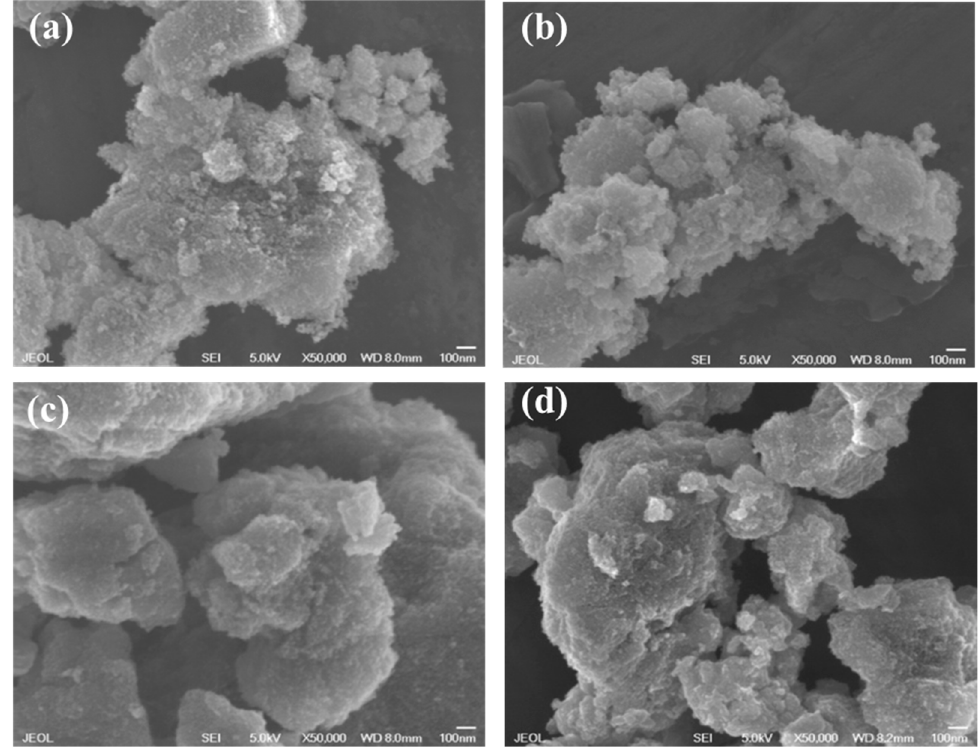
Figure 3. SEM images of catalysts ( a ) TiO 2 , ( b ) B-TiO 2 2 wt.%, ( c ) B-TiO 2 3 wt.%, and ( d ) B-TiO 2 5 wt.%. 5